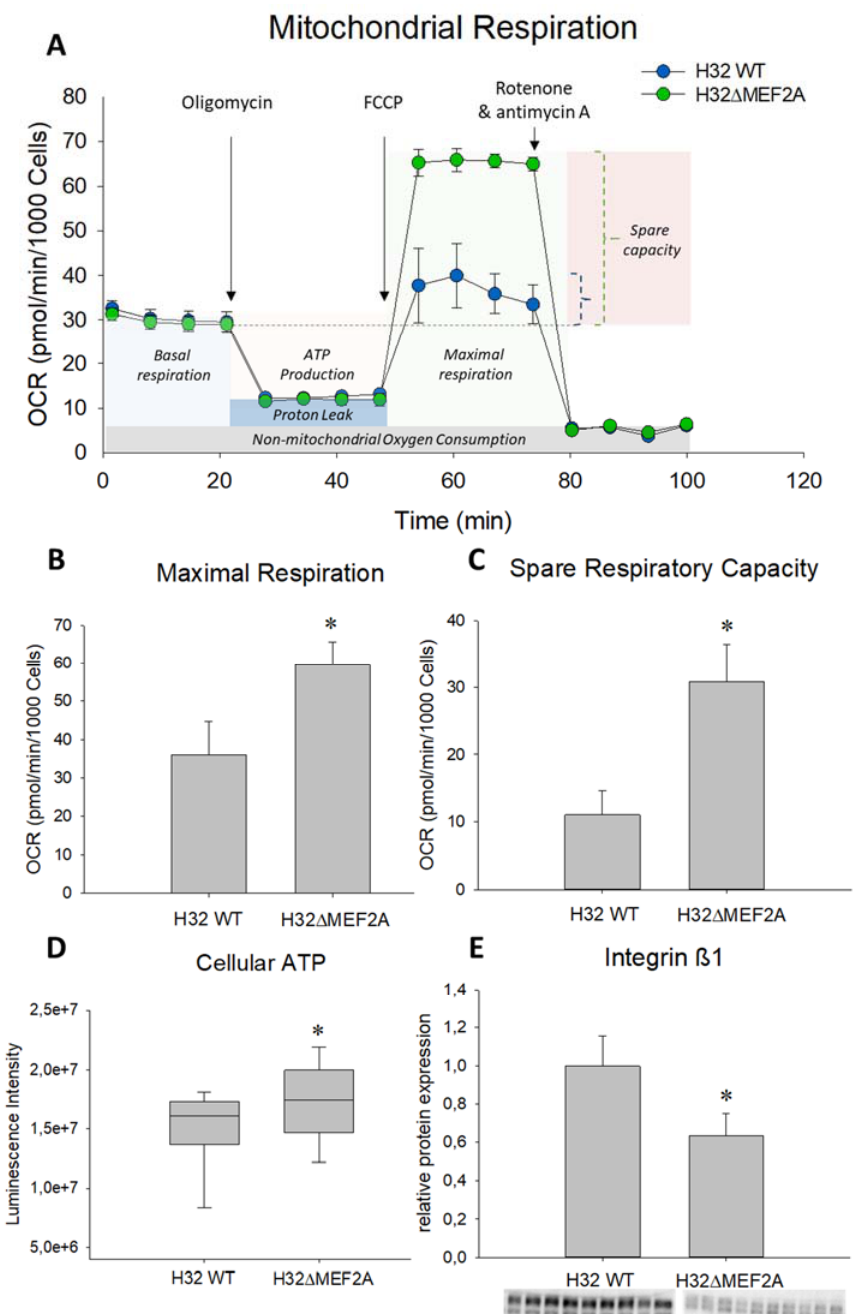
Figure 4. Effect of MEF2A knockout on mitochondrial function and neuronal connectivity. ( A ) The Agilent Seahorse XF Cell Mito Stress Test profile shows the oxygen consumption rate (OCR) in H32 wild ‐ type (WT) and H32 Δ MEF2A cells representing key parameters of mitochondrial function. ( B ) and ( C ) The OCR of both cell lines in the mitochondria stress test measured by Seahorse. H32 Δ MEF2A cells show a significantly increased maximal respiration (* p = 0.004) and spare respiratory capacity (maximal vs. basal respiration, * p = 0.01) compared to H32 cells. n = 3 test repetitions with 4 measurement replicates per group. ( D ) Cellular ATP content under basal conditions is significantly higher in H32 Δ MEF2A than H32 WT cells. n = 24 per group; * p = 0.038. ( E ) Relative protein expression of integrin ß1 is significantly downregulated in H32 Δ MEF2A cells compared to H32 WT cells. n (H32 WT) = 9, n (H32 Δ MEF2A) = 10; * p < 0.001.